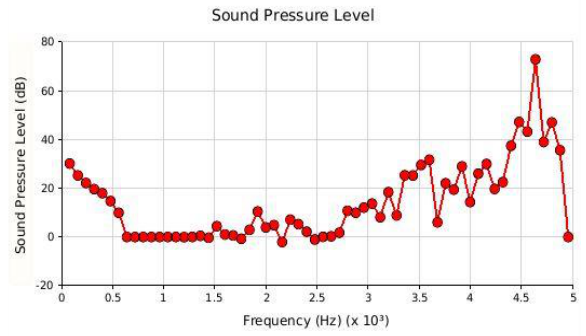
Figure 23. Peak load electromagnetic noise at 1600 rpm.